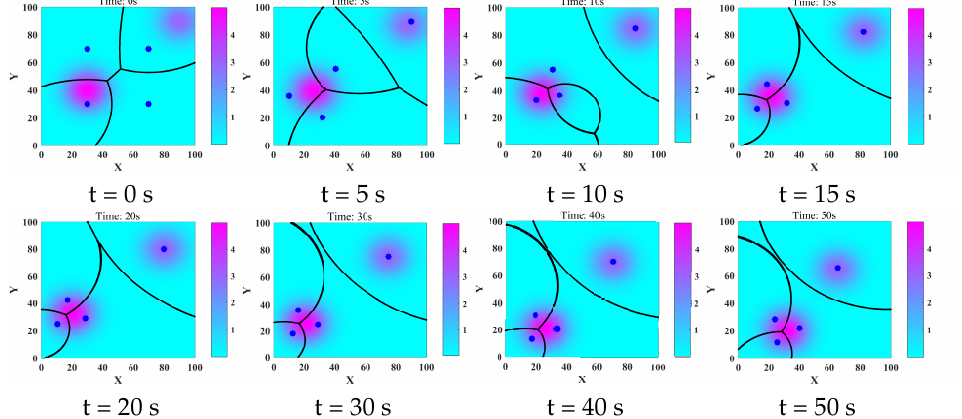
Figure 4. The coverage evolution process of the robot network to the task area, where the blue point “ • ” represents the position of the robot, and different colors in the area represent different risk